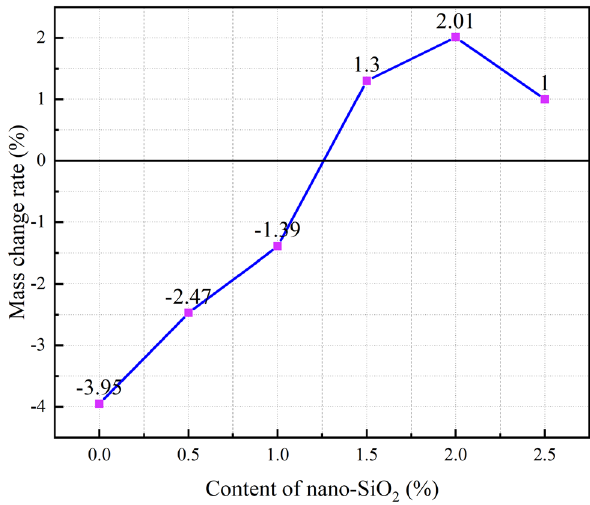
Figure 19: E ff ect of nano - SiO 2 content on resistance to sulfate ero - sion properties of geopolymer [ 99 ] .